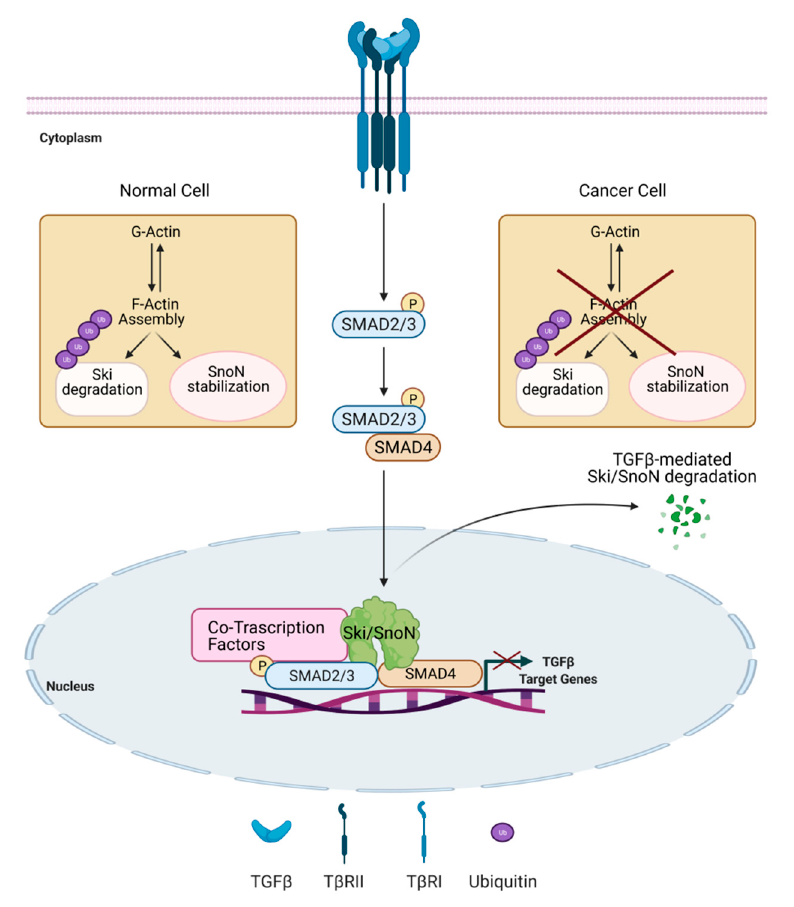
Figure 3. Actin cytoskeleton dynamics control the expression levels of Ski and SnoN, negative regulators of TGF β signaling. TGF β signaling controls expression levels of the negative regulators Ski and SnoN, by inducing both their upregulation and their ubiquitin (Ub)-mediated degradation. In normal hepatocytes, actin cytoskeleton dynamics induce Ski protein degradation and SnoN protein stabilization, and might impact TGF β signaling outcome. This mechanism is lost in hepatoma cells [151,152].